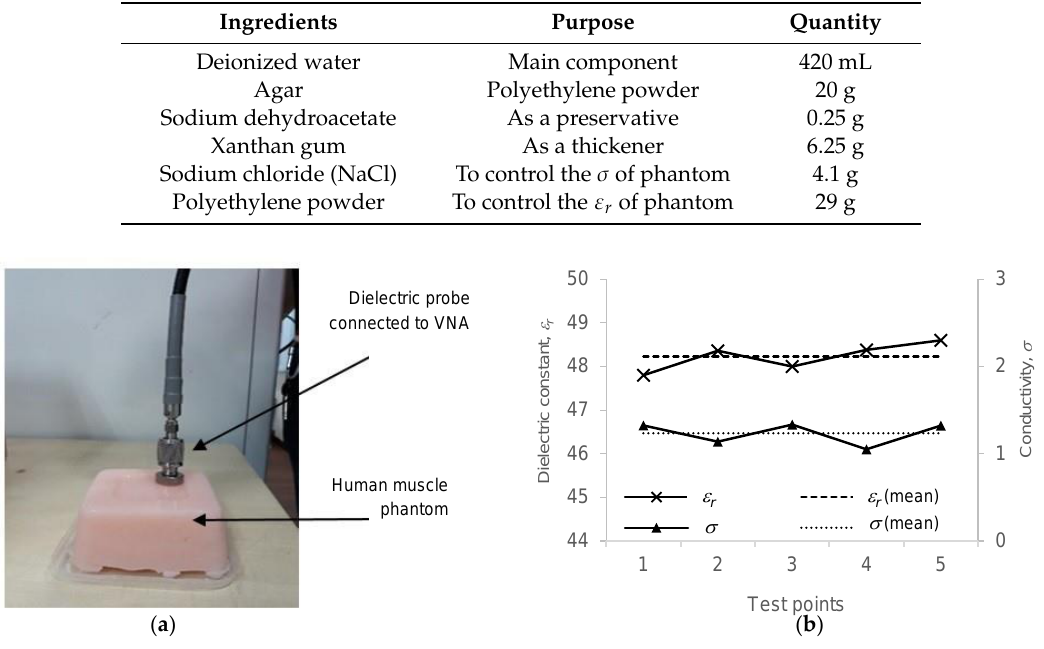
Figure 8. ( a ) Measurement of dielectric properties of the muscle phantom. The readings were taken at five different locations on the phantom’s surface to ensure the accuracy of the data; ( b ) Graph showing the measured ε r and σ , and comparison with the mean